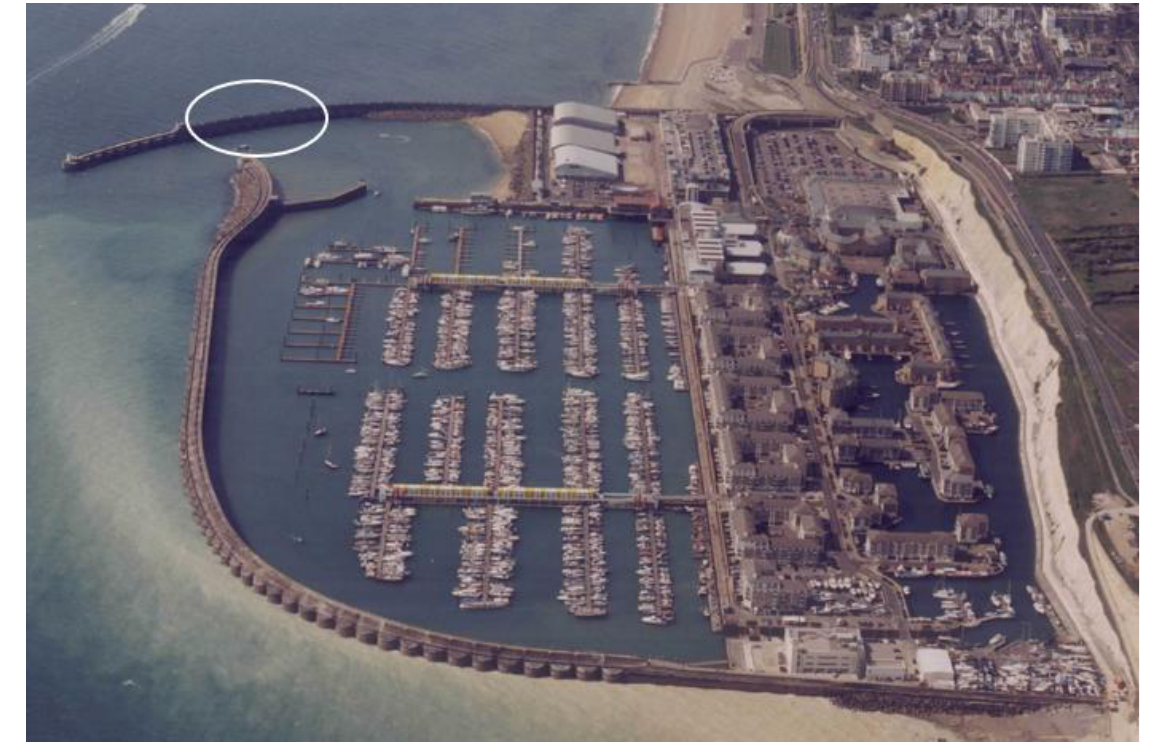
Figure 2. Outer Harbour, Inner Harbour and Tidal Harbour of Brighton Marina viewed from the east (outer part of West Breakwater modelled in this study is ringed) (courtesy of Brighton Marina Estates Management).